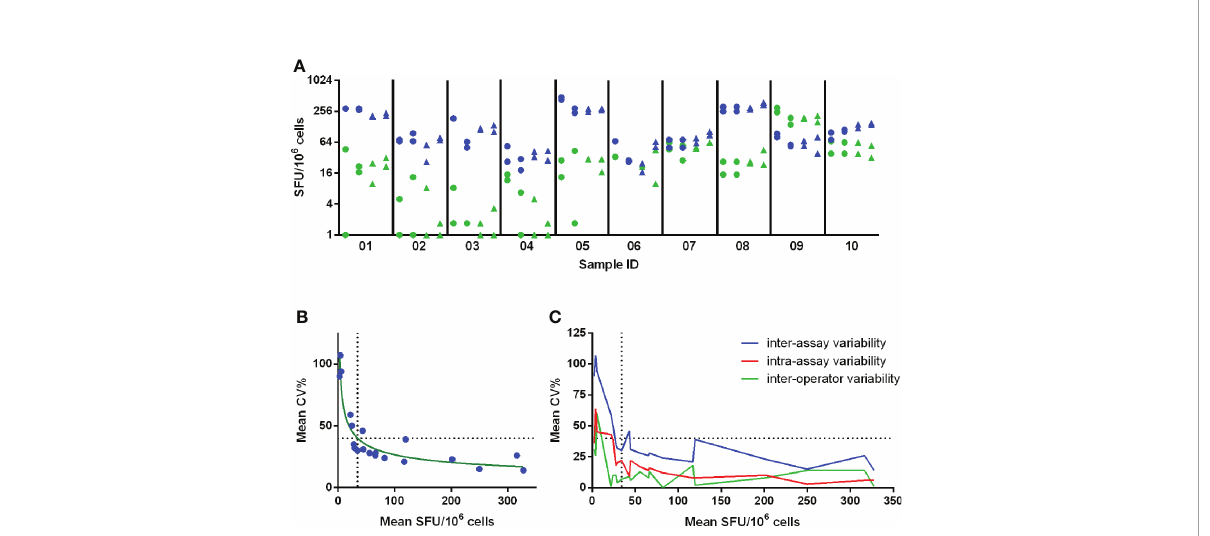
FIGURE 5 Determination of Lower Limit of Intermediate Precision (LLOIP). (A) Distribution of background-subtracted responses after in vitro stimulation of cells with A/California and tetanus toxin (TT). Each symbol represents a measurement of a certain sample, indicated on the x-axis. A set of 10 samples was tested each in duplicate by 2 operators performing each 2 runs on different days, resulting in 8 measurements per sample. Measurements from operator 1 are indicated with circles and from operator 2 with triangles. Responses obtained after stimulation with A/ California are indicated in blue, with TT in green. (B) LLOIP was determined by plotting the mean background-subtracted responses to A/ California and TT against the mean inter-assay CV% per sample. The LLOIP was de fi ned as the lowest response with a CV of 40% and was determined at 34.4 SFU/10 6 cells. (C) The inter-assay, intra-assay and inter-operator variability were assessed by the mean CV% observed for the mean responses of each sample. Each horizontal dotted line represents the cut-off of 40% CV and each vertical dotted line represents the LLOIP determined at 34.4 SFU/10 6